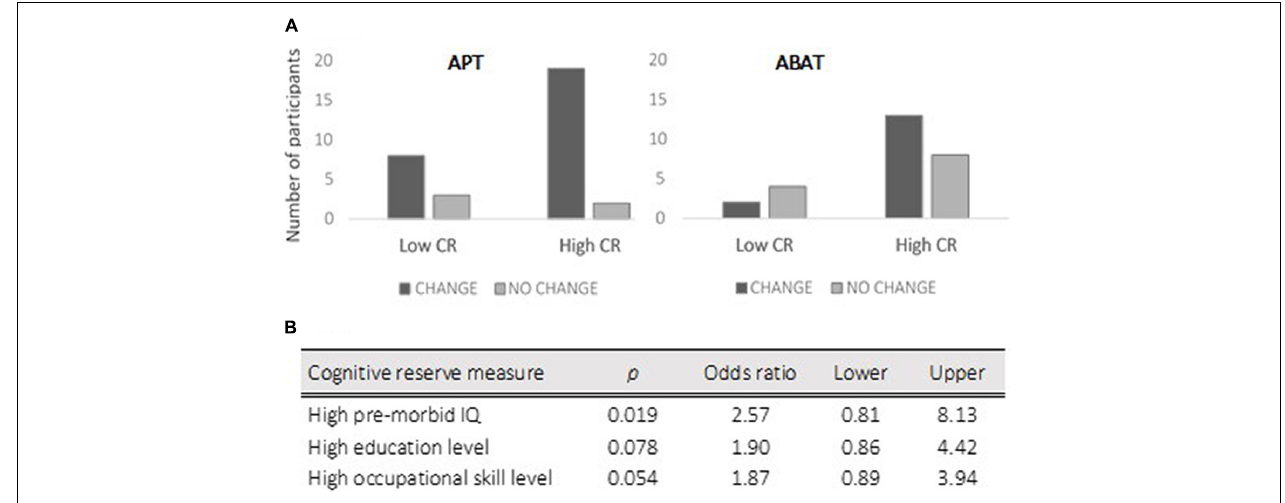
FIGURE 4 | The upper chart of the figure (A) presents the distribution of patients in the CHANGE vs. NO CHANGE groups when patients were divided into high vs. low cognitive reserve (CR) for each treatment (APT, Attention Process Training; ABAT, Activity-Based Attention Training). The lower part (B) presents the logistic regression analysis results for cognitive reserve measures with a 95% confidence